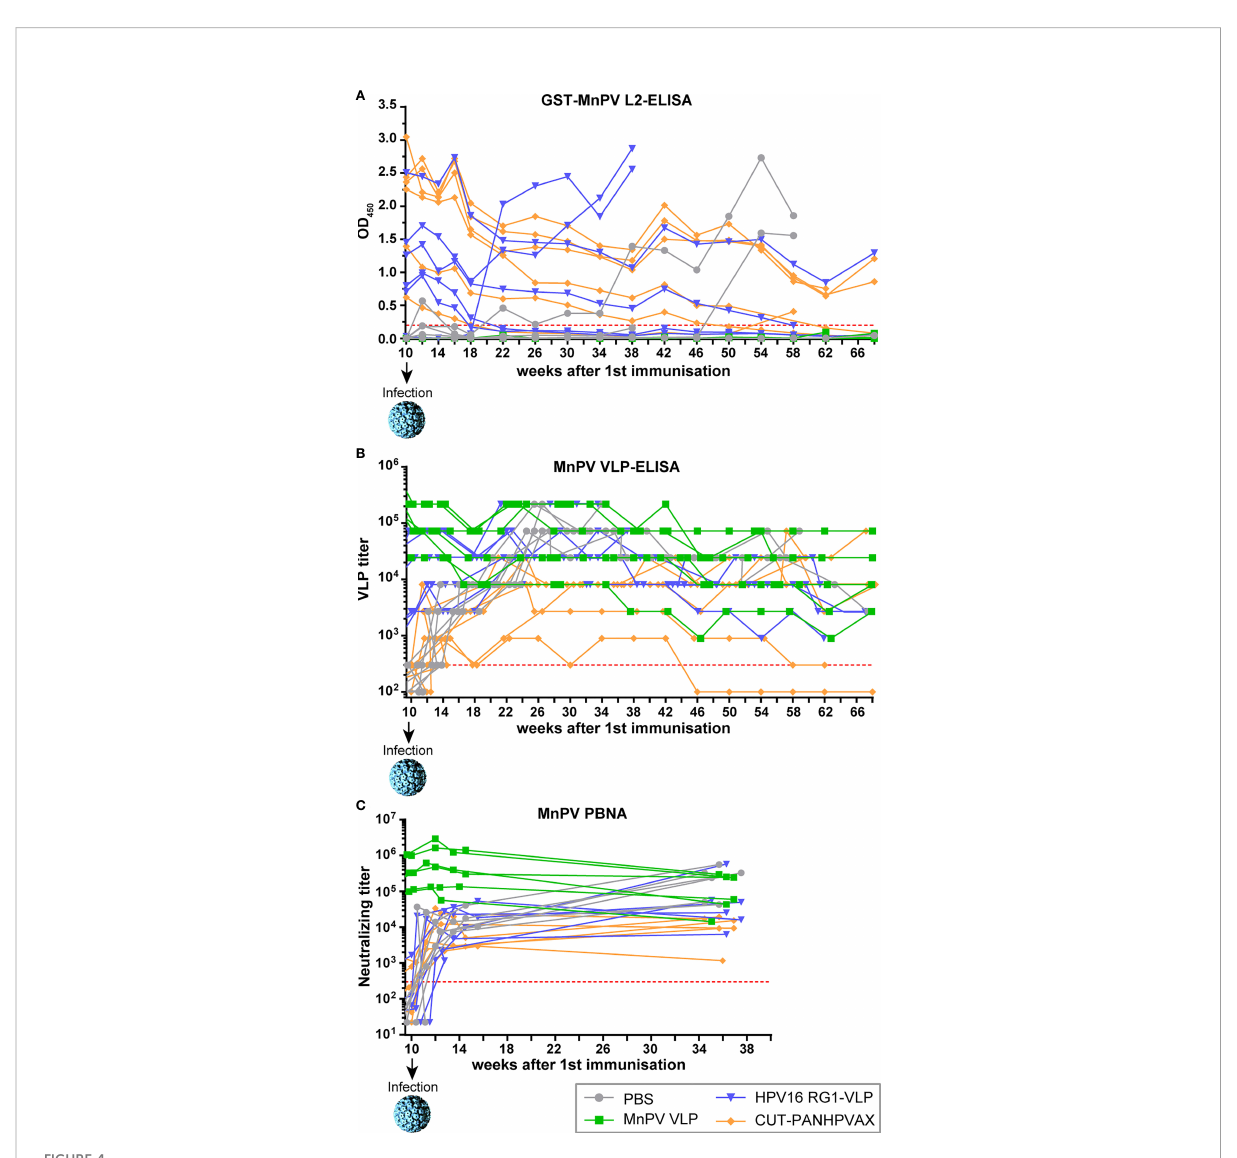
FIGURE 4 Monitoring of seroresponses of vaccinated animals after MnPV infection. At indicated time points, sera were measured by (A) GST-MnPV L2- ELISA, (B) MnPV VLP-ELISA and (C) MnPV PBNA. Prior to experimental infection at week 10, animals were vaccinated four times in bi-weekly intervals (see Figure 2) with MnPV VLP (green), HPV16 RG1-VLP (blue), CUT-PANHPVAX (orange) or PBS (grey). All groups consist of n=6 animals. Dashed lines represent the methods ’ cut-off (OD 450 = 0.2 for GST-ELISA; titer of 300 for MnPV VLP-ELISA and MnPV